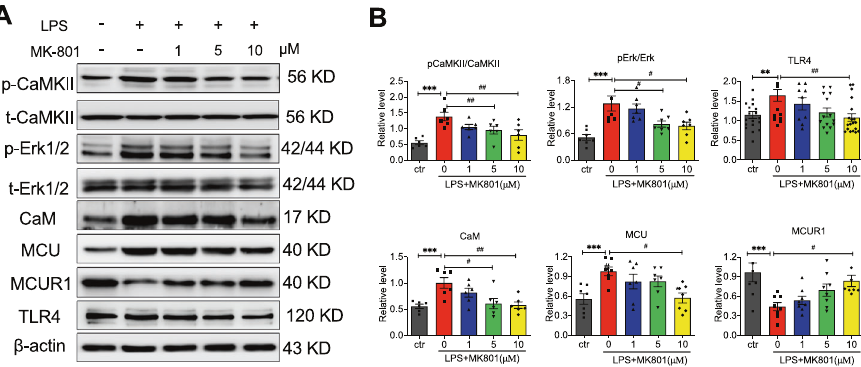
Fig. 3 Molecular signal pathway in MK801 regulated dysfunction of HUVEC induced by LPS. A Representative of western blotting images and B analysis of phosphorylation of Erk1/2 (p-Erk1/2) and CaMKII (p-CaMKII), and expression of CaM, MCU, MCUR, and TLR4 in HUVECs exposed to LPS in the presence or absence of different concentrations of MK801. (Data are presented as mean ± SEM, *** P < 0.001, ** P < 0.01, * P < 0.05 vs. Control; ### P < 0.001, ## P < 0.01, # P < 0.05 vs.